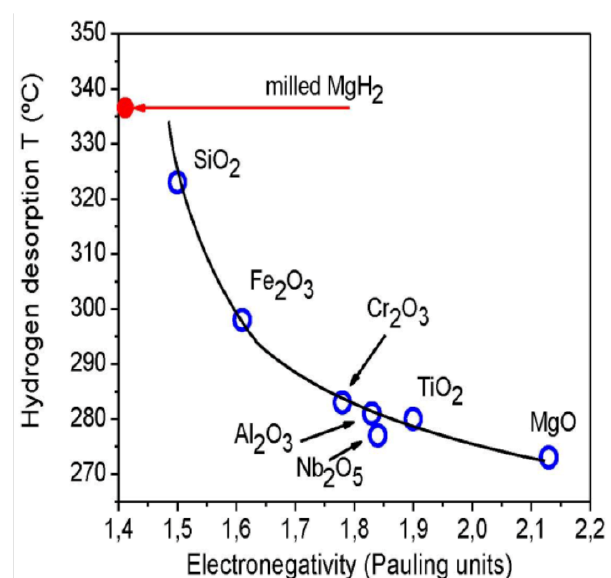
Figure 37. Correlation of the desorption temperature of hydrogen from MgH 2 , achieved upon oxide addition during milling and the electronegativity of the oxide additives. Reproduced with permission [273]. Copyright 2012,